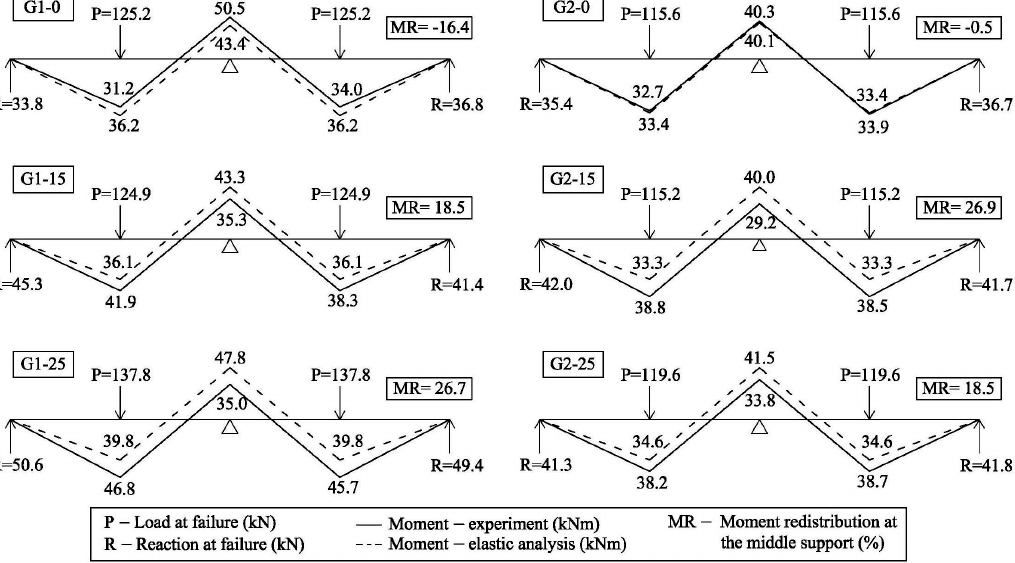
Figure 6. Experimental versus elastic bending moments at failure.